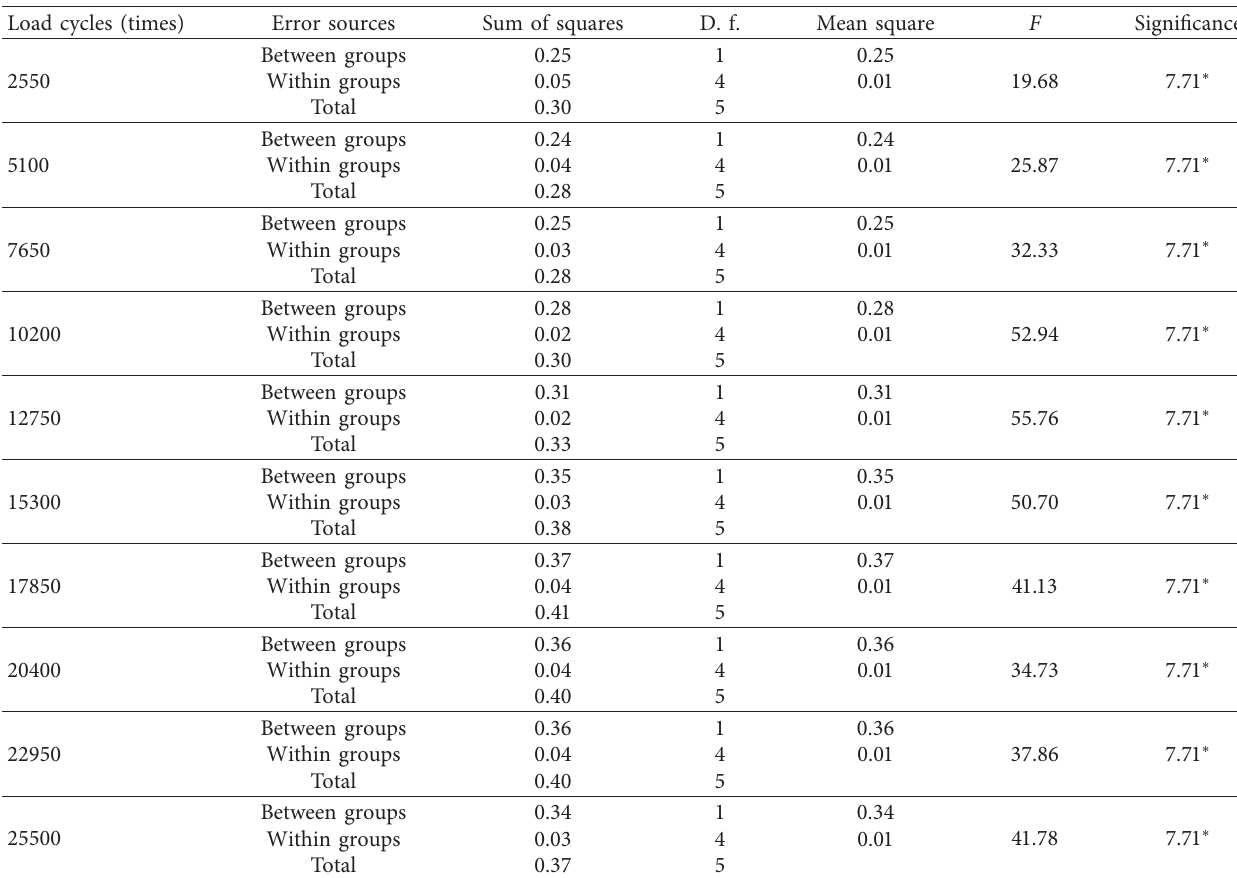
Table 9: Differences between the rut depths of two pavement structures with the same number of load cycles (load pressure � 0.7MPa). Load cycles